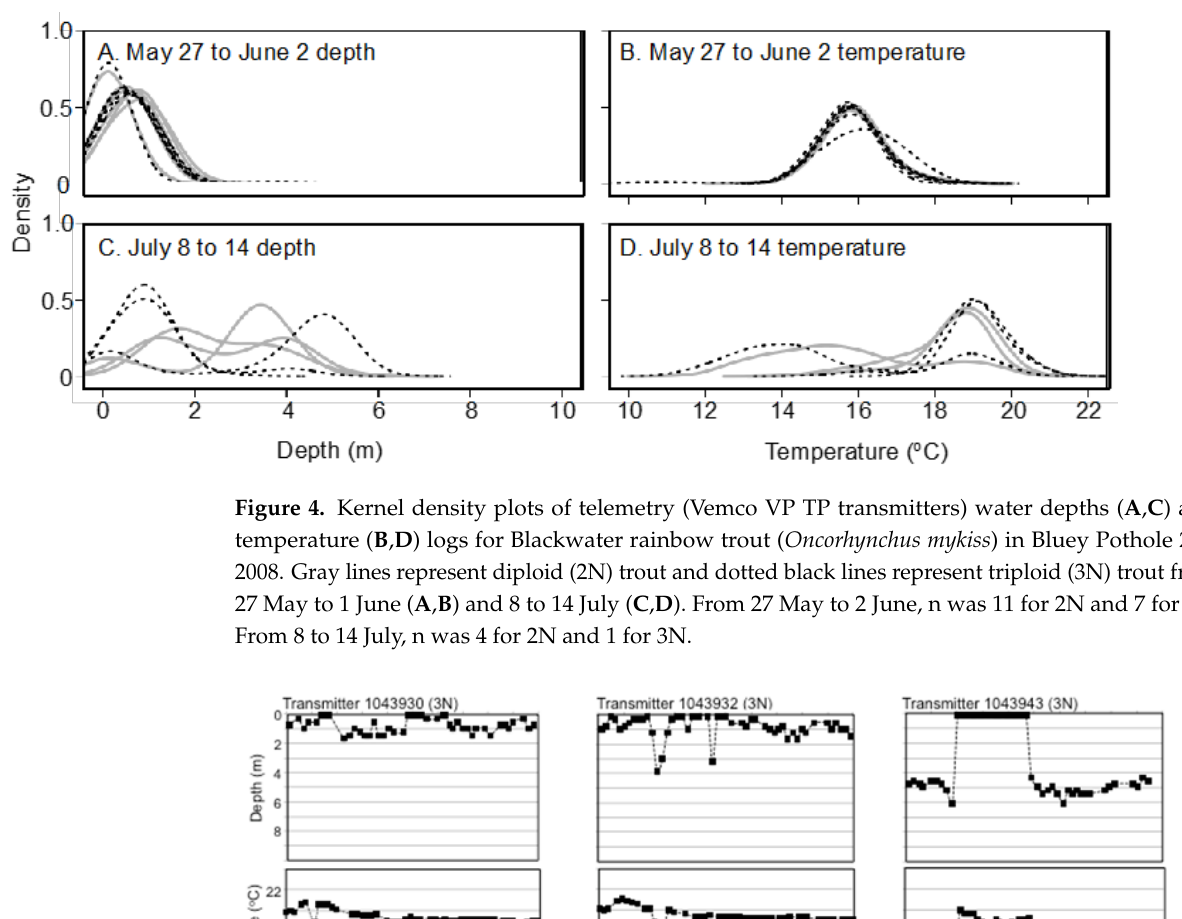
Figure 3. Kernel density plots of telemetry (Vemco VP TP transmitters) water depths ( A , C ) and temperature ( B , D ) logs for Blackwater rainbow trout ( Oncorhynchus mykiss ) in Pete’s Pothole 2 in 2008. Gray lines represent diploid (2N) trout and dotted black lines represent triploid (3N) trout from 27 May to 1 June ( A , B ) and July 8 to 14 ( C , D ). From 27 May to 2 June, n was 11 for 2N and 7 for 3N. From 8 to 14 July, n was 4 for 2N and 1 for 3N.